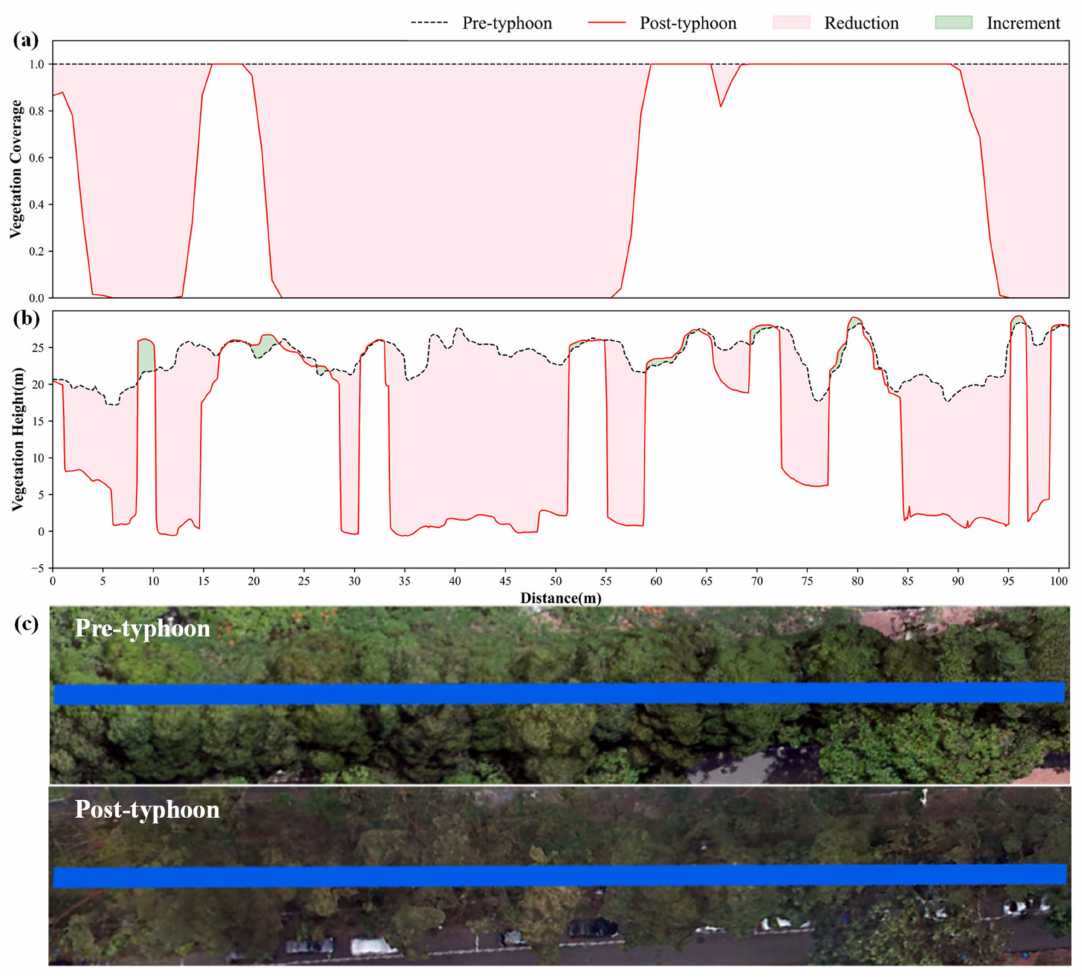
Figure 5. Changes in coverage and canopy height of the roadside trees on the sampling line before and after the typhoon. ( a ) The vegetation coverage; ( b ) the canopy height; and ( c ) the sampling